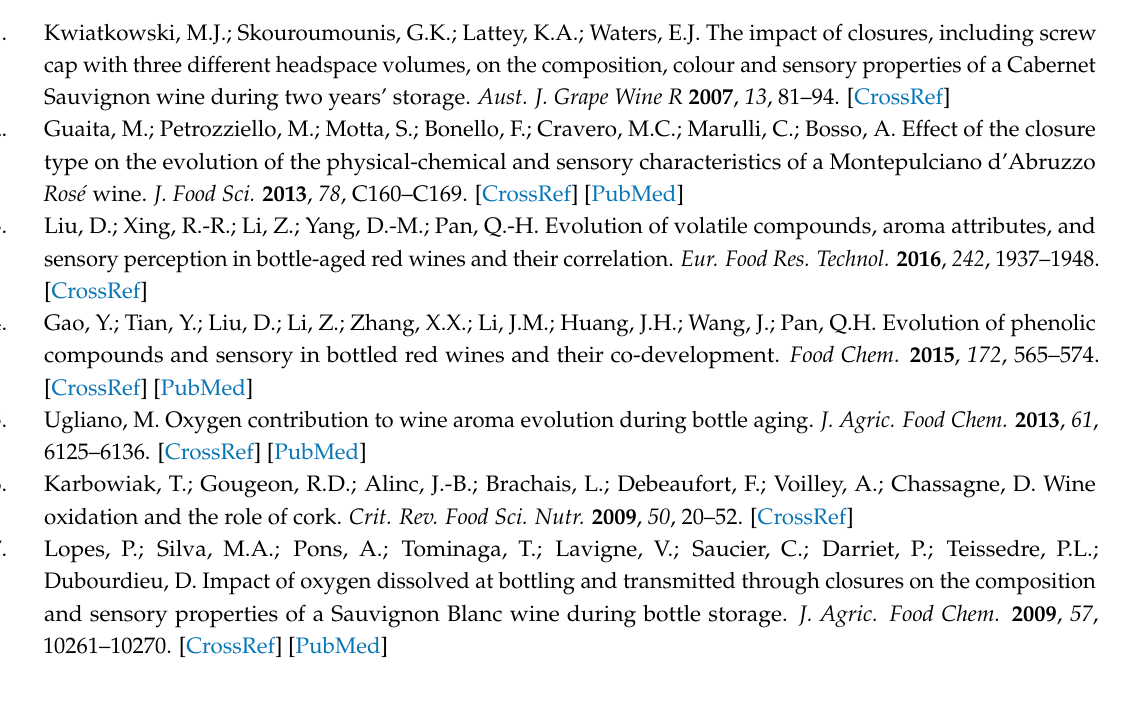
Supplementary Materials: Supplementary Materials are available online. Table S1: Phenolic compounds identified in this work; Table S2: Volatile compounds identified in this work and their aroma parameters; Table S3: Detailed information of two original wine samples; Table S4: Physical index of various bottle closures used in this